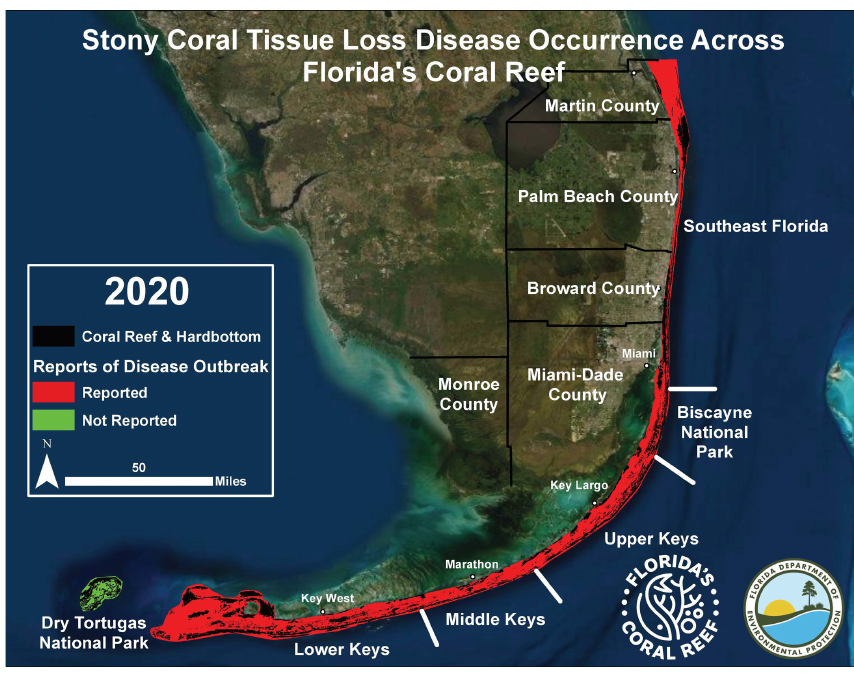
Figure 1b: Time series animation showing the progression of stony coral tissue loss disease. Graphic updated September 16, 2020. Source: Florida Department of Environmental